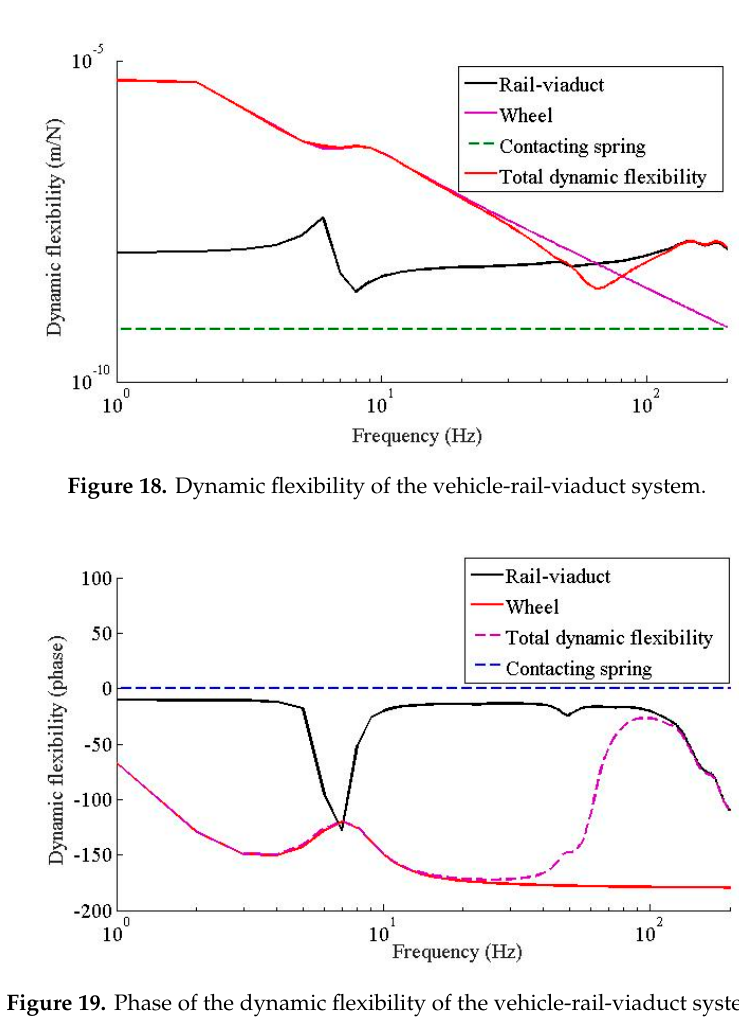
Figure 19. Phase of the dynamic flexibility of the vehicle-rail-viaduct system.